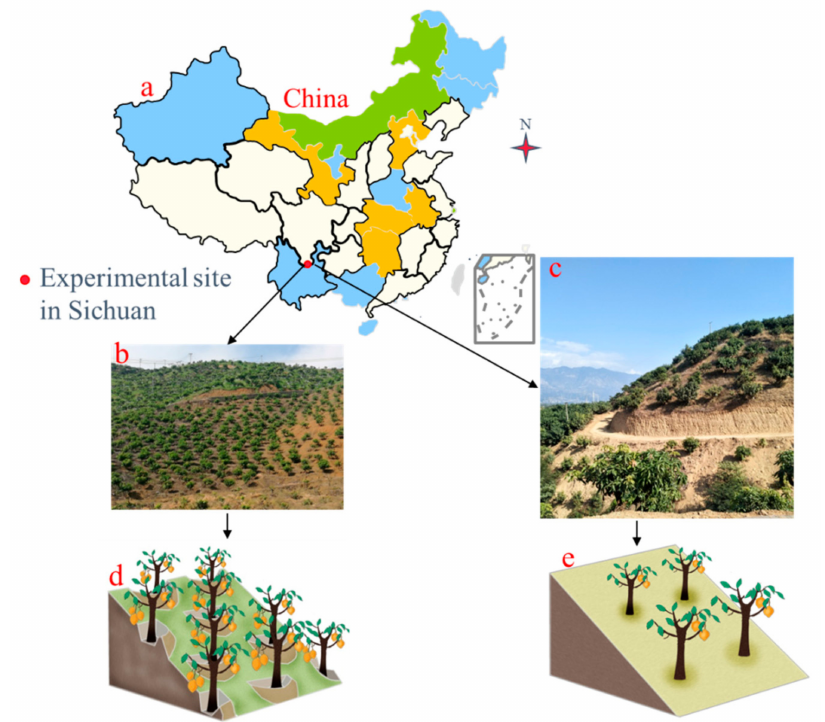
Figure 1. Location of the study sites in China ( a ) in the Jinsha River of Southwest China. Photo of a mango tree on fish-scale pits ( b ) and natural slopes ( c ). Schematic diagram of a mango tree on fish-scale pits ( d ) and natural slopes ( e ).